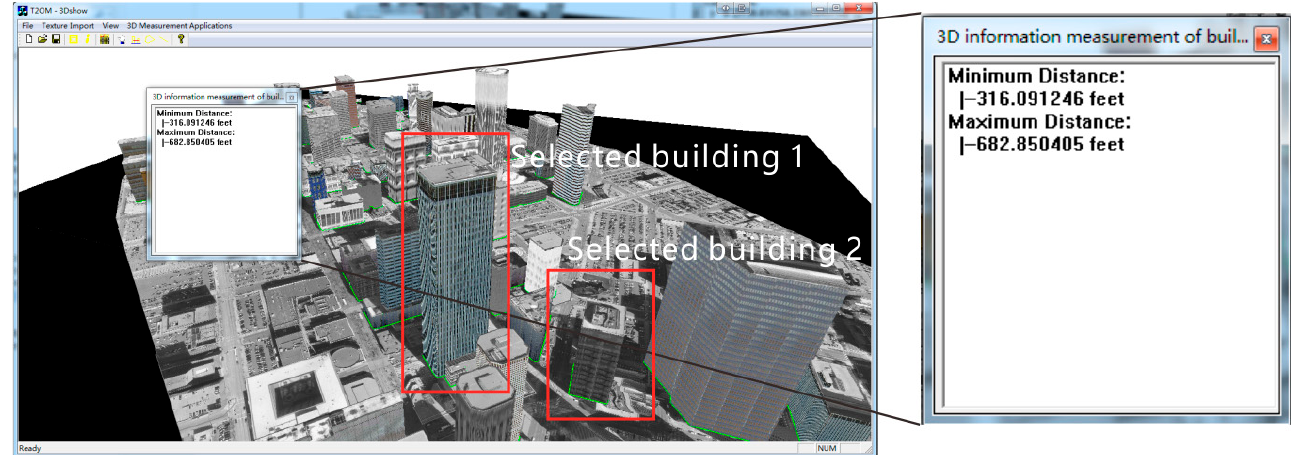
Figure 25. Measuring the maximum and minimum distances between two buildings.